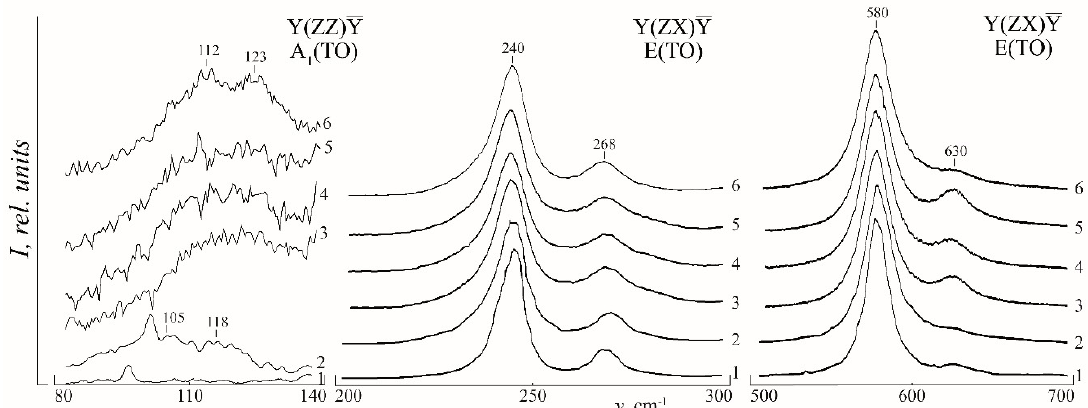
Figure 5. Raman spectra fragments of the crystals SLN (1), CLN (2), and LiNbO 3 :B (0.55 (3), 0.69 (4), 0.83 (5), 1.24 (6) mol%) in the scattering geometries Y(ZX) ¯Y and Y(ZZ)¯Y. Figure is reproduced with the permission of Pleiades Publishing from the paper N. V. Sidorov et al., Opt. Spectrosc . 2016 V. 121 P. 36–44, DOI: https://doi.org/10.1134/S0030400X16070195 (accessed on 26 March 2021). Table 1. Basic parameters of E(TO) bands appearing in Raman spectra of crystals SLN, CLN, and LiNbO 3 :B (0.55–1.24 mol%) in the Y(ZX)¯Y scattering geometry. Table is reproduced with the permission of Pleiades Publishing from the paper N. V. Sidorov et al., Techn. Phys . 2018 V. 63 P. 1758– 1766, DOI: https://doi.org/10.1134/S1063784218120198. SLN CLN